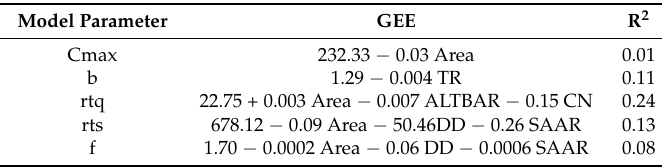
Table 9. The GEEs for PDM model parameters when using C4 as the validation